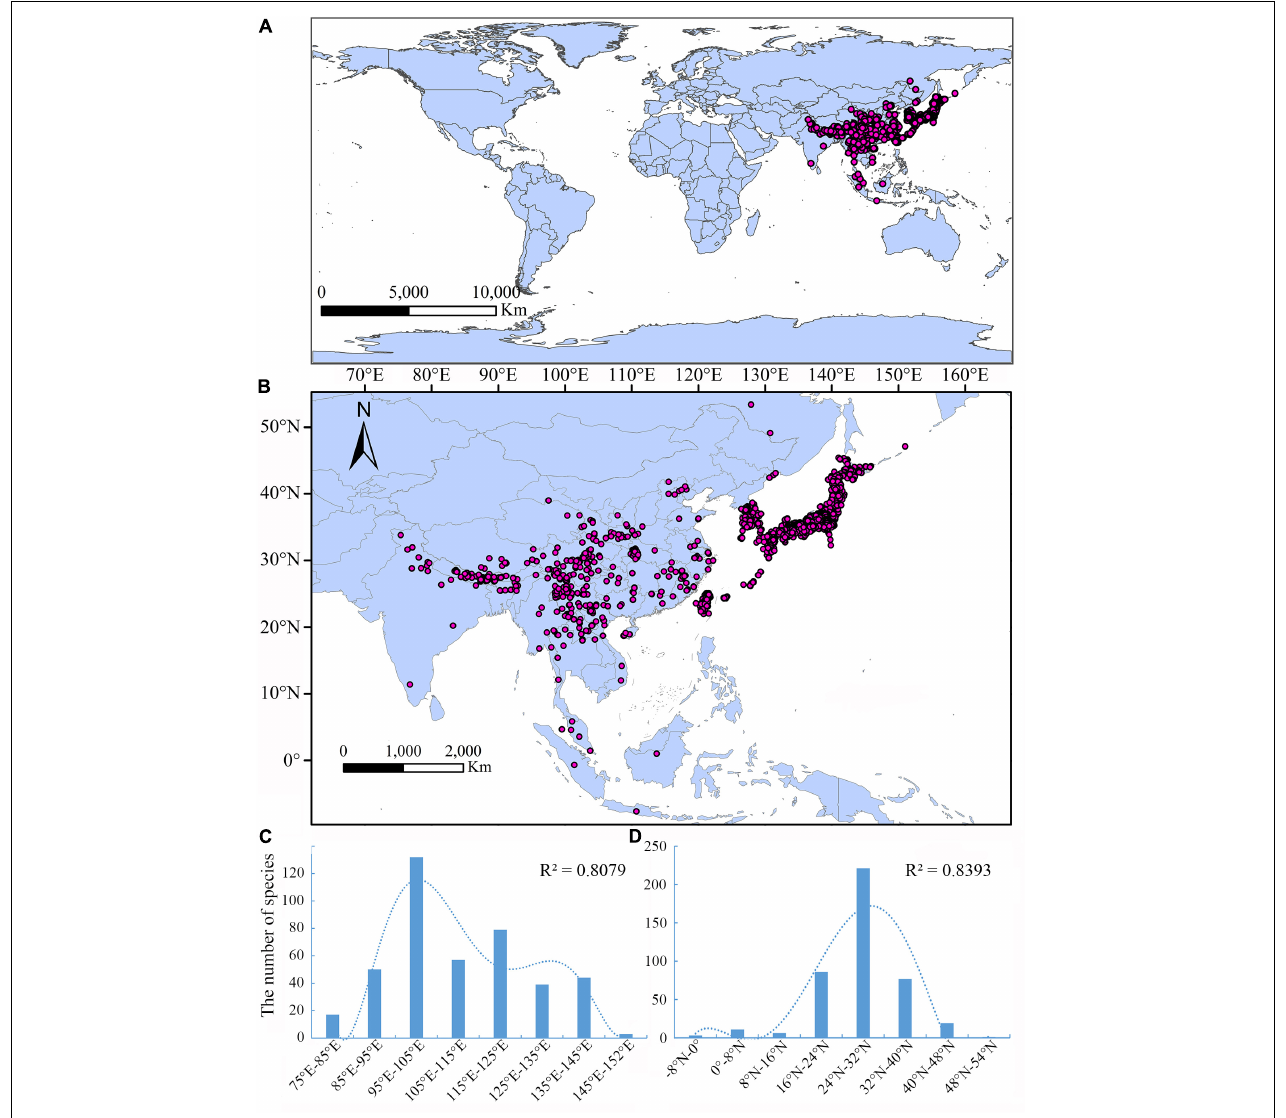
FIGURE 2 | (A) General distribution pattern of Lycocerus in the world. (B) Distribution pattern of Lycocerus in a close view. (C) The number of Lycocerus species at different longitudes. (D) The number of Lycocerus species at different